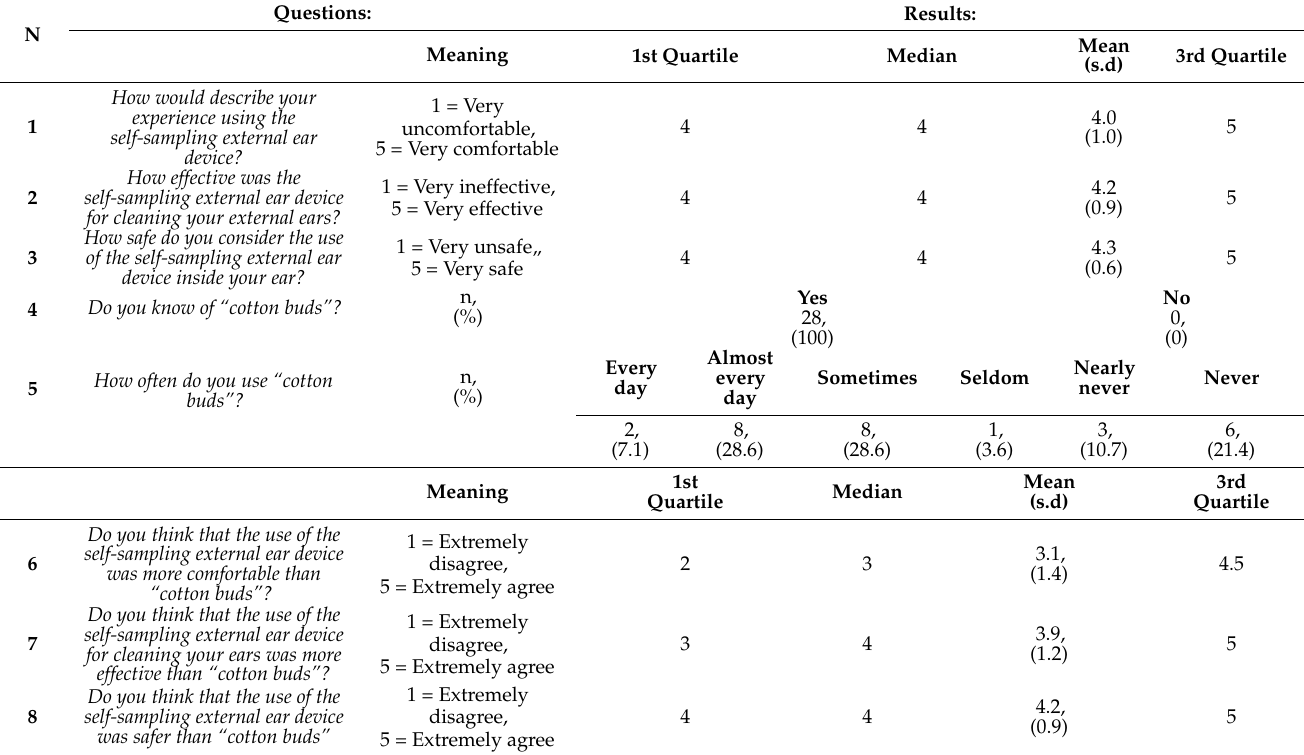
Table 3. The Self-Sampling External Ear Device Satisfaction Survey.